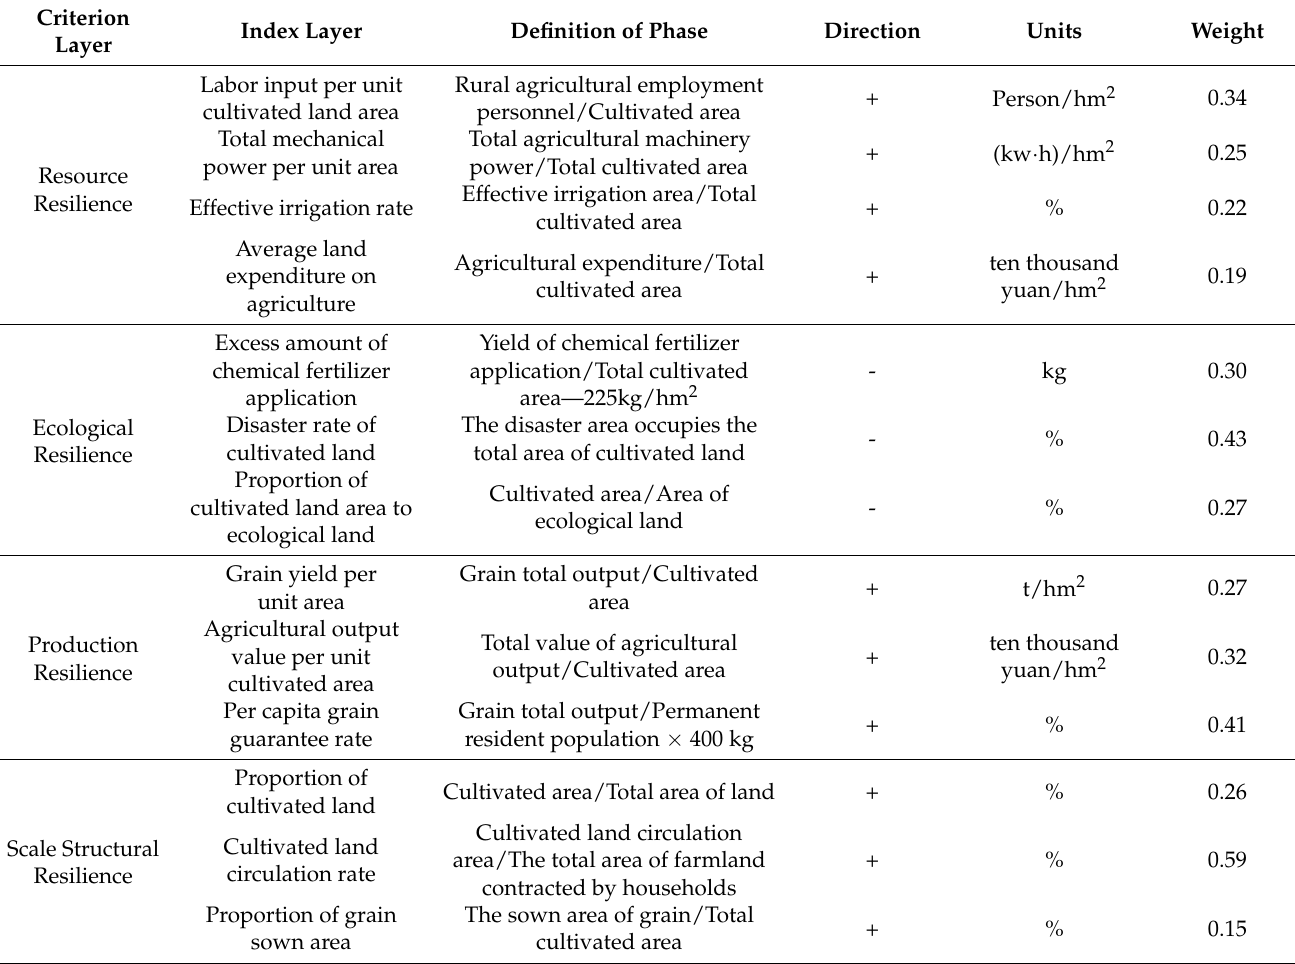
Table 1. Cultivated Land Use System Resilience (CLSR) Evaluation Index System.